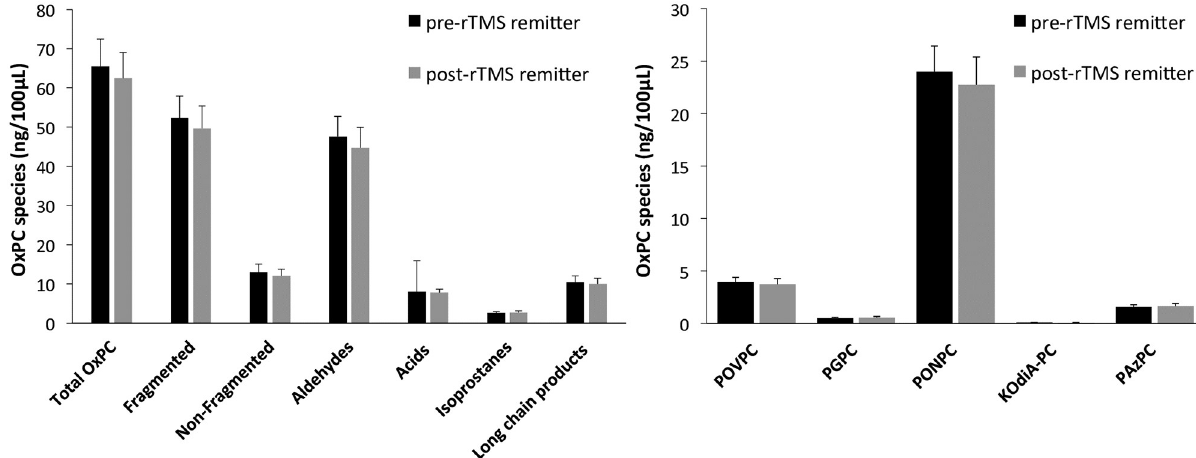
Fig 6. OxPC levels divided into total OxPCs with subgroups [A] and 5 specific OxPC compounds [B] compared between MDD remitters pre- rTMS [n = 21] and post-rTMS [n = 21]. Values are mean+SEM.